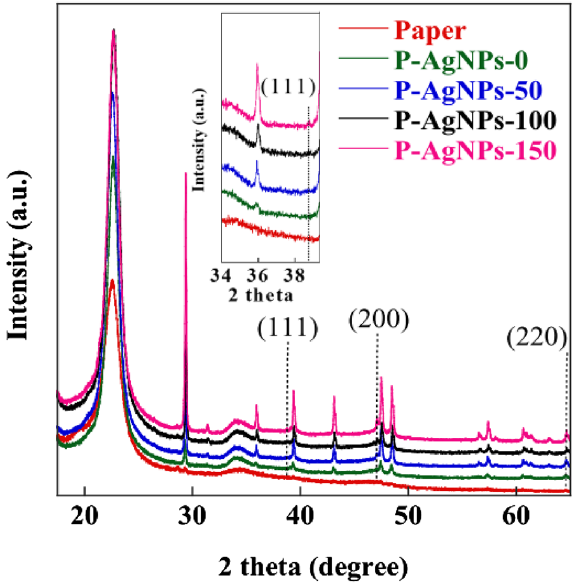
Figure 4. XRD patterns of the filter paper and P-AgNPs.